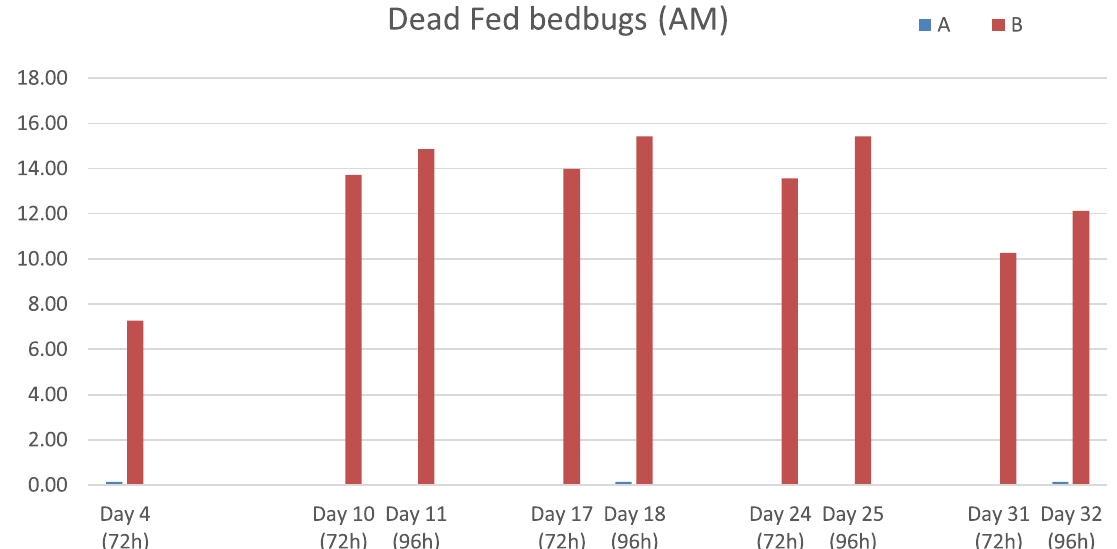
Figure 2. Number of dead fed bedbugs counted in the control group (A-blue) and the treated group